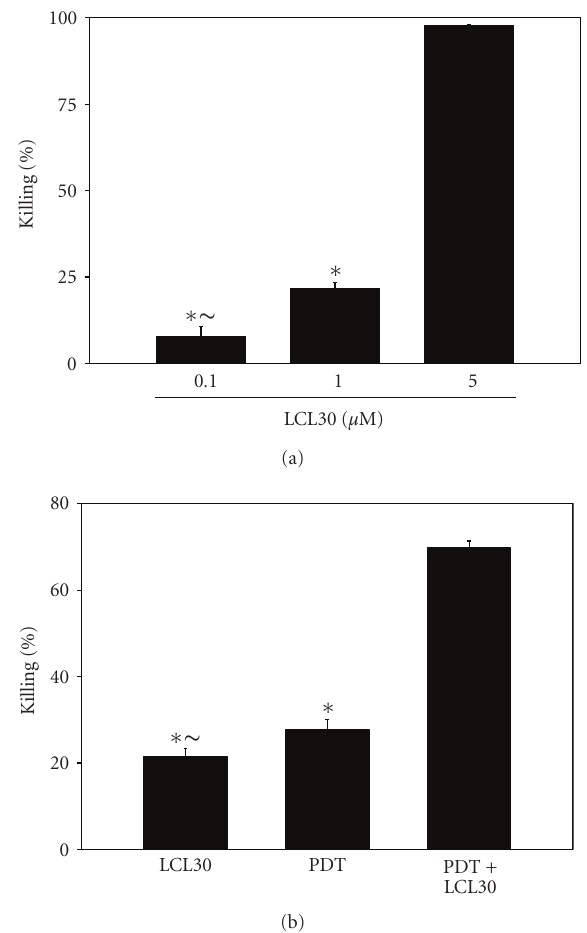
Figure 6: Overall cell killing is promoted after (PDT+LCL30). Following the addition of Pc 4 or LCL30, cells were seeded in the growth medium, preincubated overnight, and irradiated with red light (200mJ/cm 2 ). After eight days of growth at 37 ◦ C, colonies ( ≥ 50 cells) were stained with crystal violet (0.1%) and counted. The data are expressed as the percentage of killing and are shown as average ± SEM from six to 26 independent determinations. (a) Dose-dependent increase in cell killing after LCL30. The significance ( P < . 05) is shown as follows: ∗ indicates the significant di ff erence between lower doses (0.1 or 1 μ M) and the highest LCL 30 dose (5 μ M); ∼ indicates the significant di ff erence between 0.1 and 1 μ M LCL30. (b) Total cell killing is augmented after (PDT + 1 μ M LCL30). The significance ( P < . 05) is shown as follows: ∗ indicates the significant di ff erence between an individual treatment, LCL30 or PDT, and the combination (PDT+LCL30); ∼ indicates the significant di ff erence between LCL30 and